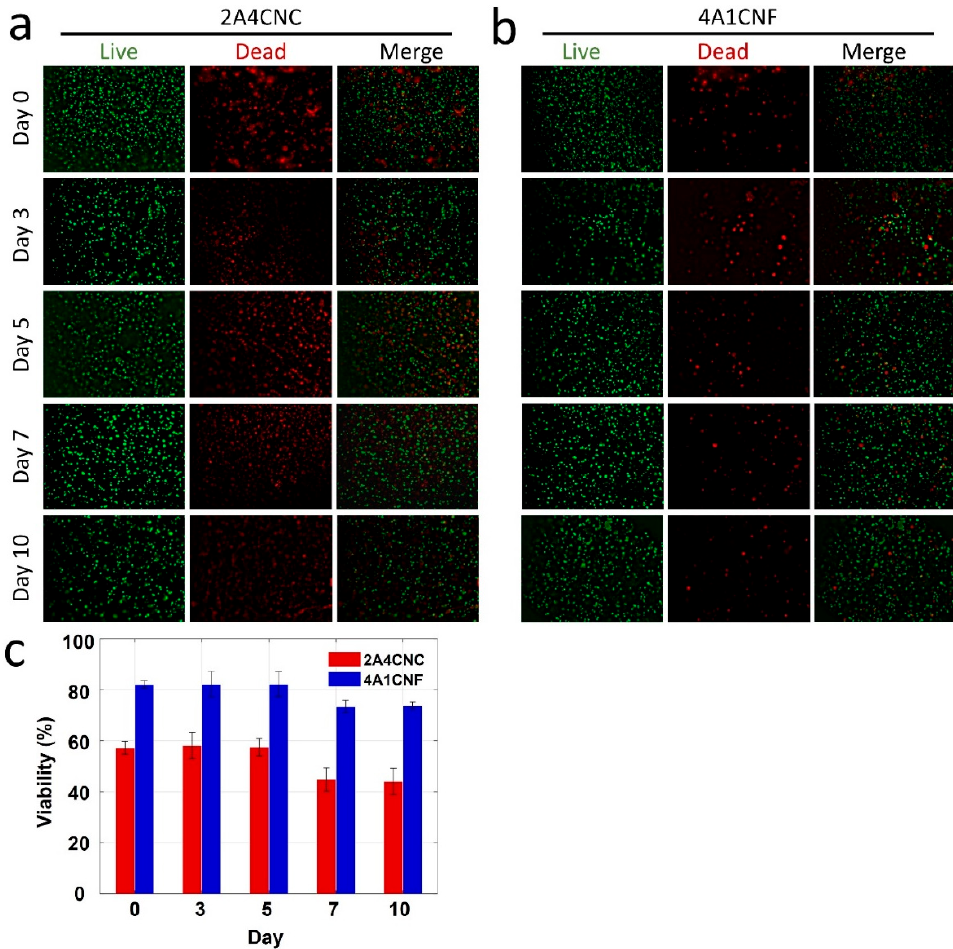
Figure 6. Characterization of cell viability. Fluorescence images of National Institutes of Health (NIH) 3T3 mouse embryonic fibroblast cells in ( a ) 2A4CNC and ( b ) 4A1CNF hydrogels, showing the cell viability after day 0, 3, 5, 7, and 10. The green-stained (Calcein AM, 0.5 µ L/mL) cell represents the live-cell shown in the first column. Red-stained (ethidium homodimer 1, 2 μ L/mL) cell represents the dead cell shown in the second column. The third column shows the merge of live and dead cells. ( c ) Quantification of the cell viability from live/dead image analysis. Statistical differences were calculated by one-way ANOVA test and t-test for multiple and two samples comparison ( p < 0.0001). Error bars represent the standard deviation of three independent measurements.